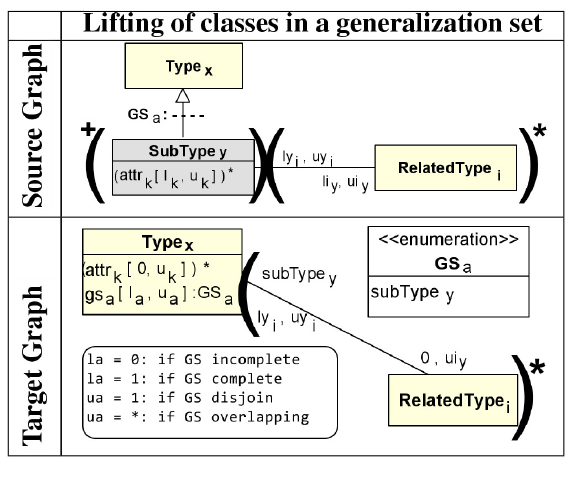
TABLE 3 The lifting operation with a generalization